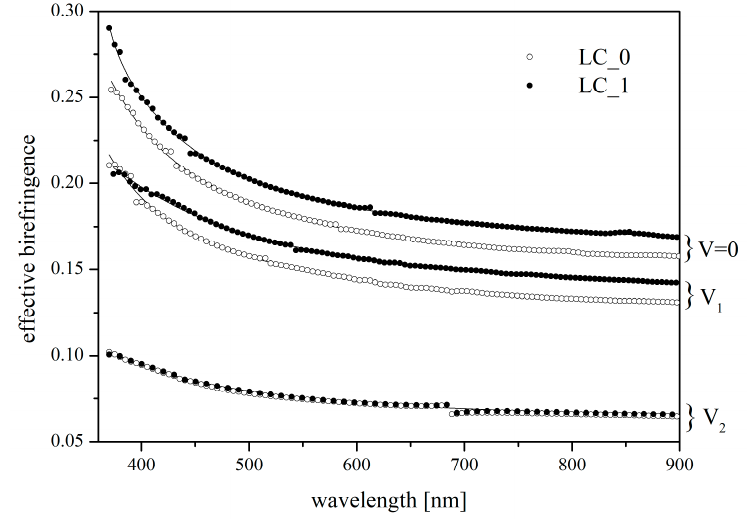
Figure 6. Birefringence (V = 0) and effective birefringence (at V 1 = 1.25 V and V 2 = 2.2 V) calculated for LC_0 and LC_1 mixtures based on the 0th-order diffraction efficiency registered in the entire spectral range. Discontinuities in the plots are related to periodicity of the cosine function.